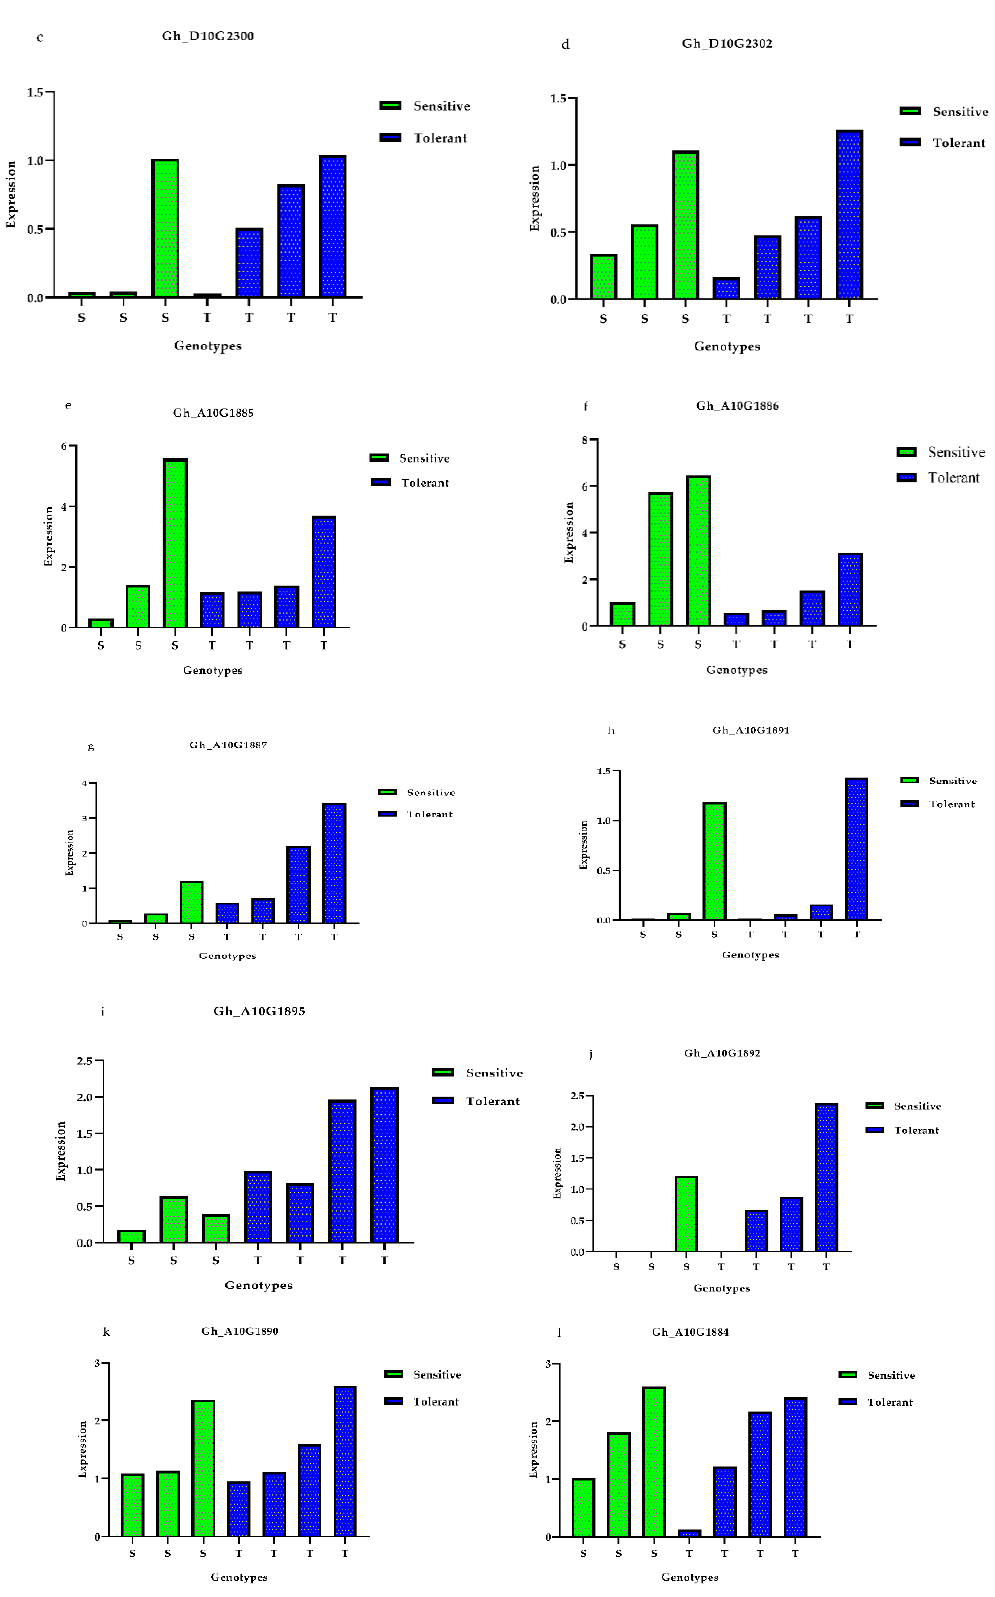
Figure 7. Relative expression of candidate genes by qRT-PCR. These figures ( a – l ) shows the relative expression of each selected candidate gene in three salt-sensitive and four salt-tolerant genotypes.